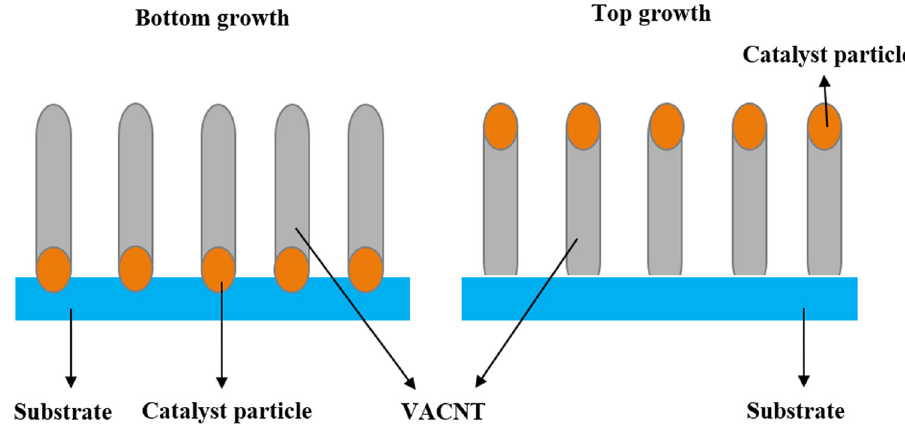
Figure 4: The growth patterns of VACNTs on substrate: bottom growth and top